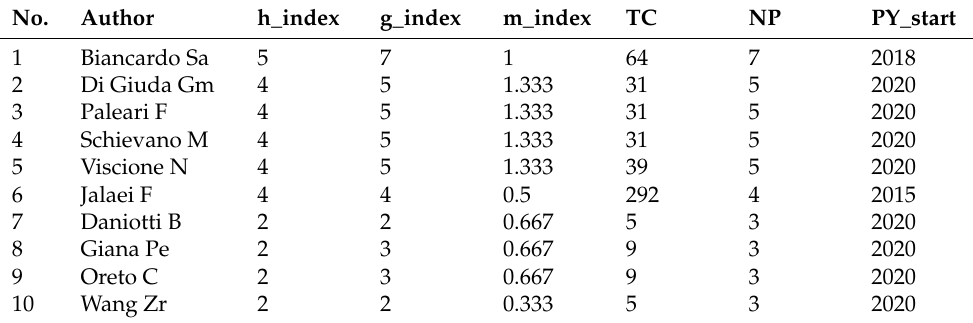
Table 5. Top 10 Specialists’ Local Impact in the WoS and Scopus.